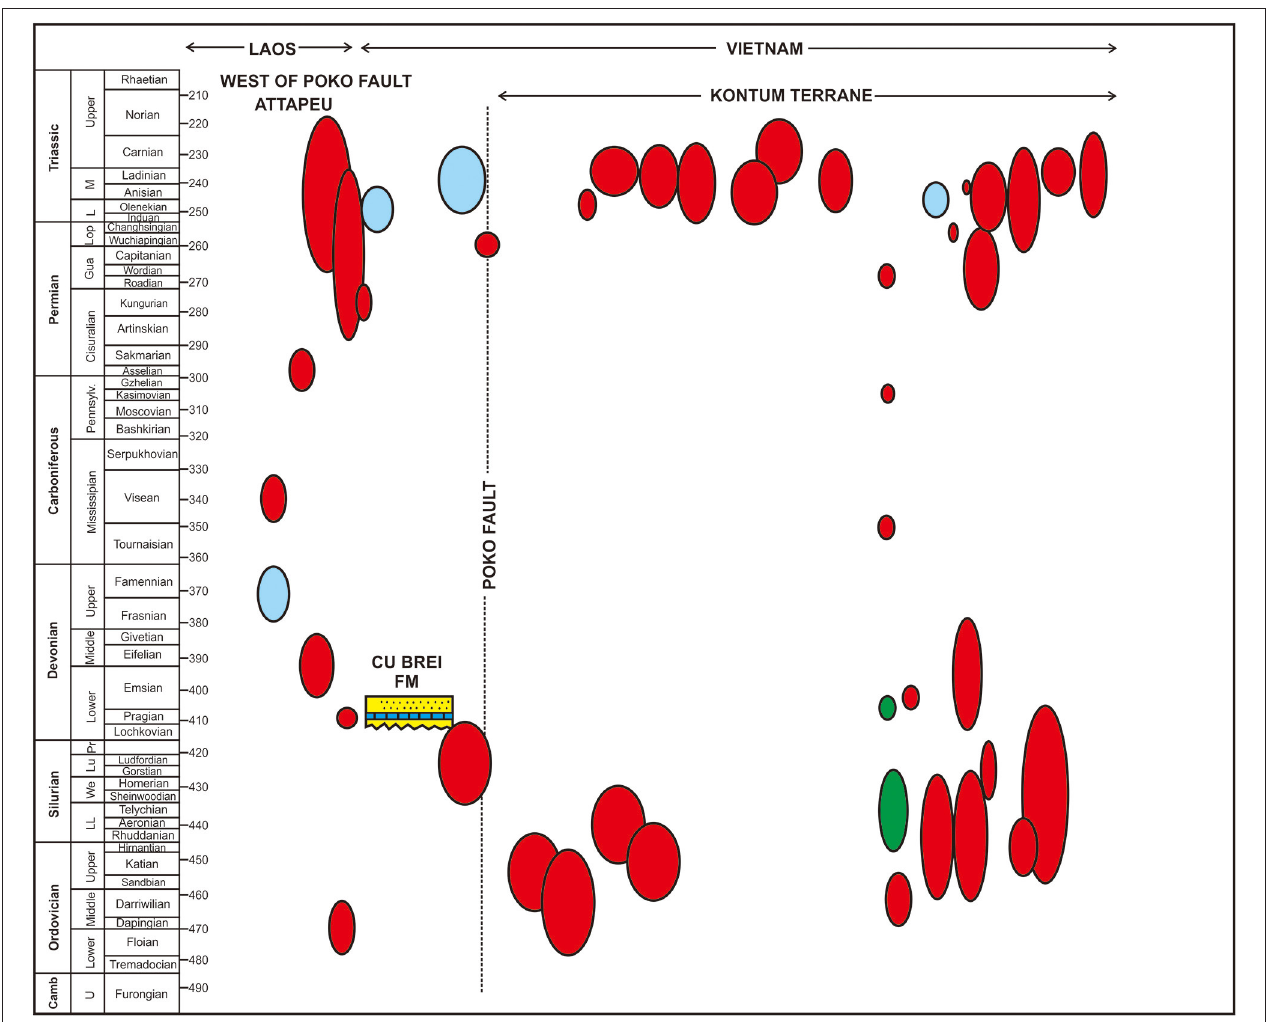
FIGURE 13 | Summary of plutonic magmatism in the Attapeu region of Laos (AT on Figure 1 ) and adjacent areas in Vietnam, west of the Poko Fault (POK on Figure 1 ) and the Kontum Terrane east of the Poko Fault. Note the significant difference in magmatic history and stratigraphy on either side of the Poko Fault. Note that the Early Devonian Cu Brei Formation is west of the Poko Fault and, unlike the Kontum Terrane, is unmetamorphosed. Palaeozoic strata do not outcrop on the Kontum Terrane. Light blue = intermediate – mafic intrusives, red = felsic/acidic intrusives, and green = amphibolites -mid-plate